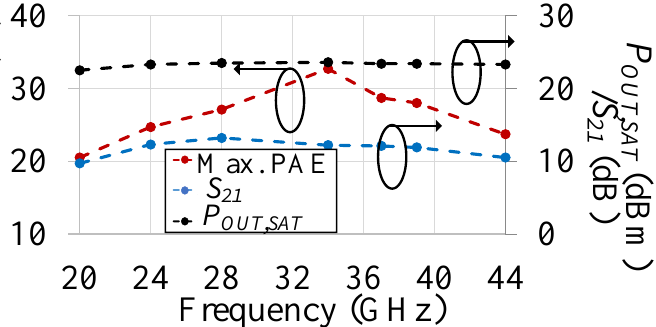
Figure 11. EM PEX simulated maximum PAE, S 21 , and P OUT,SAT vs. frequency of the broadband differential GaN PA.